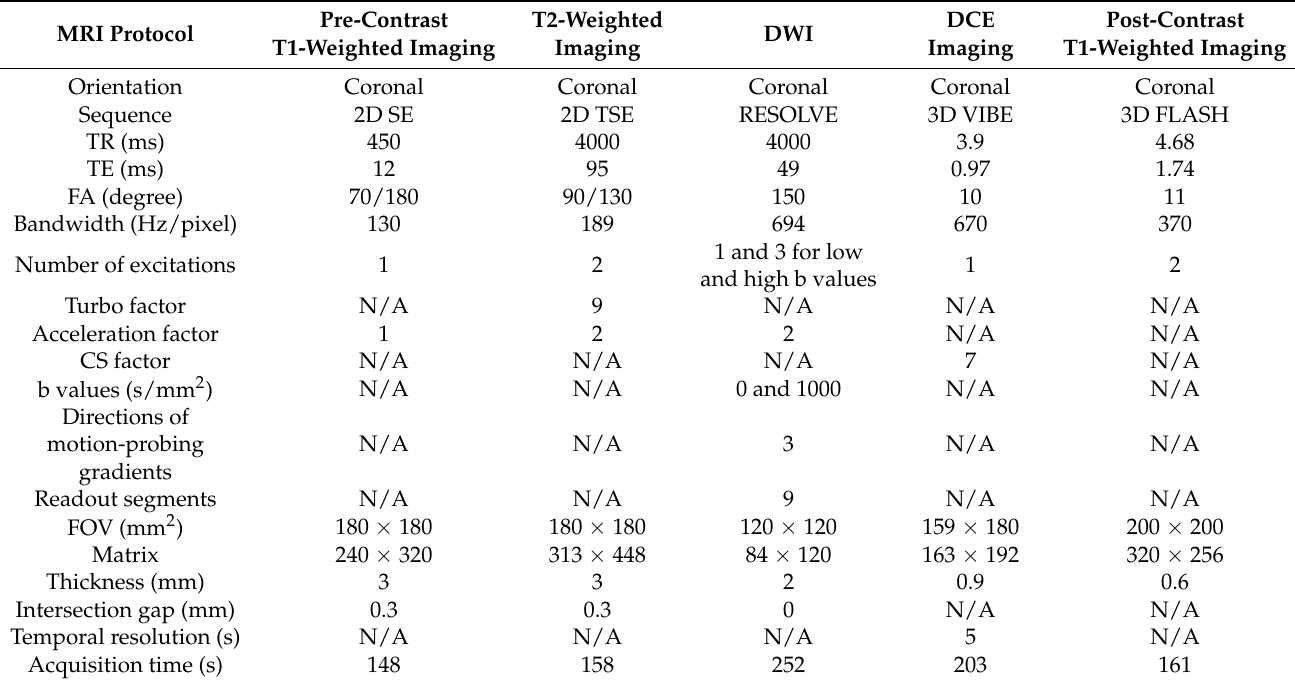
Table 1. Pituitary MRI